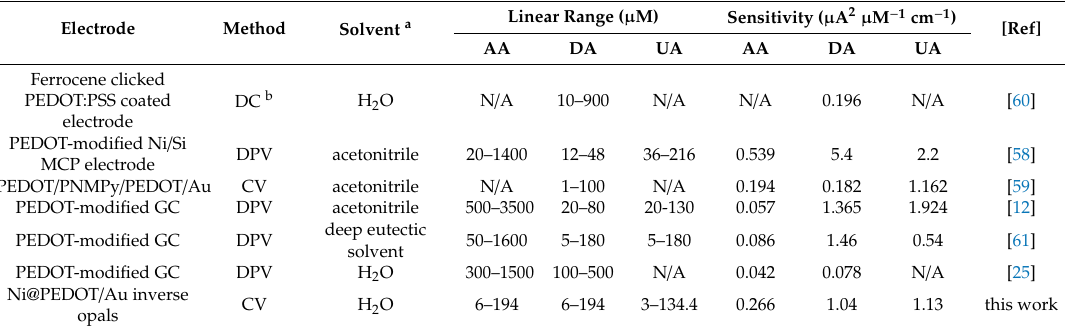
Table 5. The comparison for sensing performances of Ni@PEDOT / Au in this work with other nanostructured PEDOT-based sensors from the literatures.